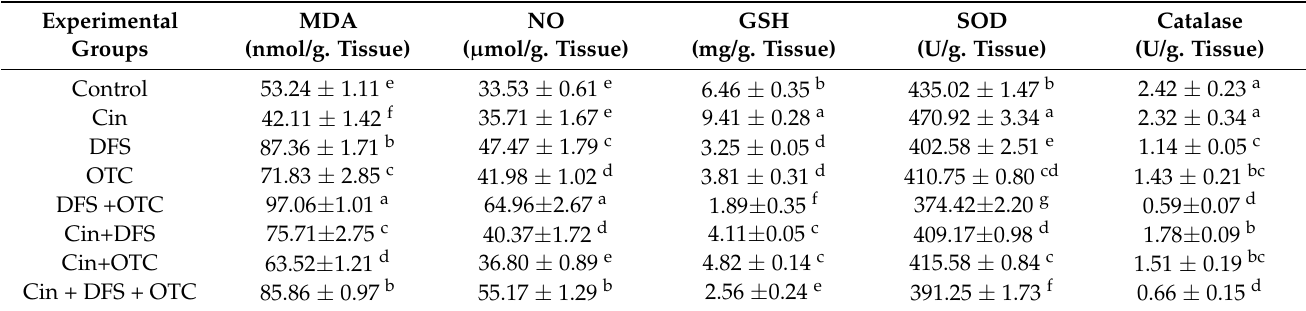
Table 4. Hepatic antioxidant and oxidative stress parameters in control and experimental group. Experimental Groups (U/g. Tissue)